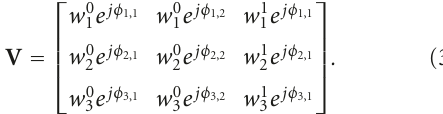
Figure 2: Visualization of optimization for the case P = 4 and N t =